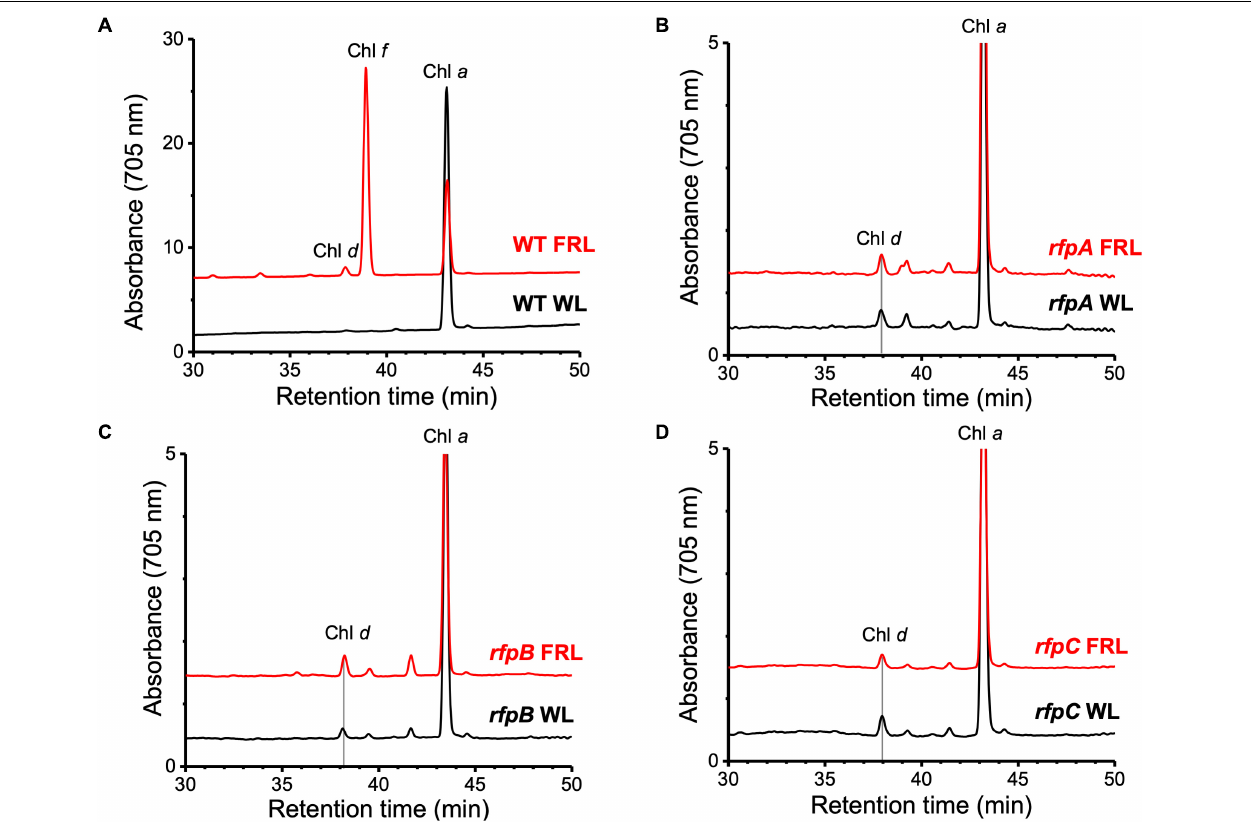
FIGURE 1 | Elution profiles at 705 nm for HPLC analyses of pigments from cells of WT, rfpA , rfpB , and rfpC strains of C. fritschii 9212 grown in WL or FRL. The growth conditions are described in the Section “Materials and Methods.” (A) WT; (B) rfpA mutant; (C) rfpB mutant; and (D) rfpC mutant. Retention times for Chl a , Chl d , and Chl f are indicated. Elution profiles for extracts from cells grown in FRL were arbitrarily displaced from those for the WL control cells, and the y -axis was expanded in silico in (B–D) to facilitate comparison. Minor peaks eluting between 39 and 42 min in the samples from mutants had absorption spectra similar to Chl a and may represent molecules with esterifying alcohols other than